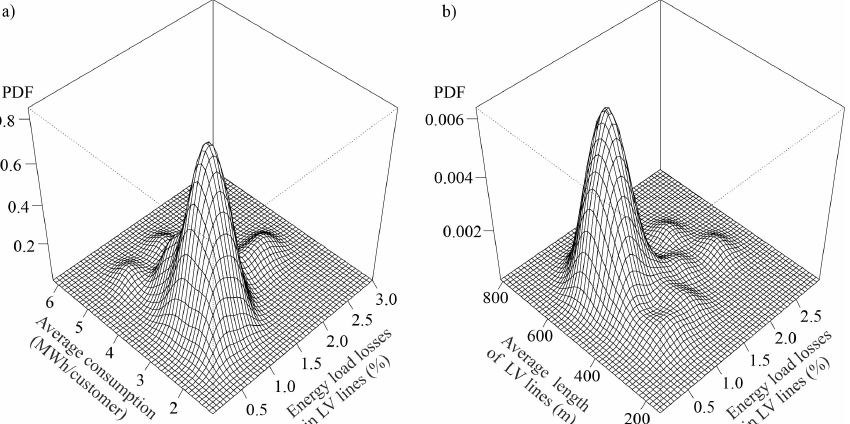
Figure 1. Two-dimensionaldensity function obtained by means of KDE function for: ( a ) average consumption and energy load losses in LV ( b ) average length of LV lines and energy load losses in LV. Smoothing coefficients H have the values for the average energy consumption